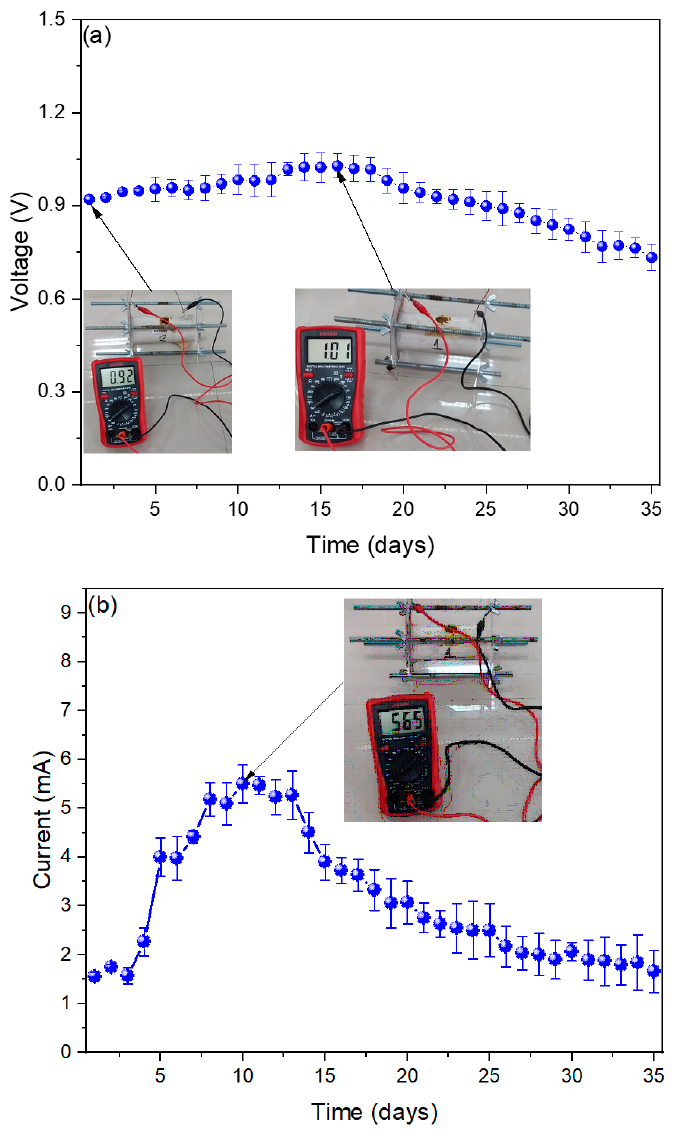
Figure 2. Monitoring of ( a ) voltage and ( b ) current values of MFCs during 35 days. Figure 3a shows the average values of conductivity of MFCs monitoring for 35 days. The values increase from the first day (152. 7 ± 1.01 mS/cm) to the eighth day (180.25 ± 7.9 mS/cm) and, then, they decrease until the last day (87.32 ± 4.56 mS/cm). According to Stefanova et al. [30], probably, the increase in electrical conductivity is due to reducing the internal resistance of fuel (organic waste). Likewise, in other studies, it has been clearly proven that the electrochemical parameters of MFC could be improved by the addition of inorganic salts to the substrate of the anode chamber [31]. Figure 3b shows the pH values of MFCs during monitoring. As can be seen, values increase from a moderately acidic level on the first day of (3.848) to a slightly alkaline level on the last day (8.227 ± 0.35). In the research conducted by Margaria et al. (2017), it was observed that for each substrate there is an optimum pH for the generation of electric current in MFC that for each sub- strate. Based on this, we could say that the optimum pH for our research was on the tenth